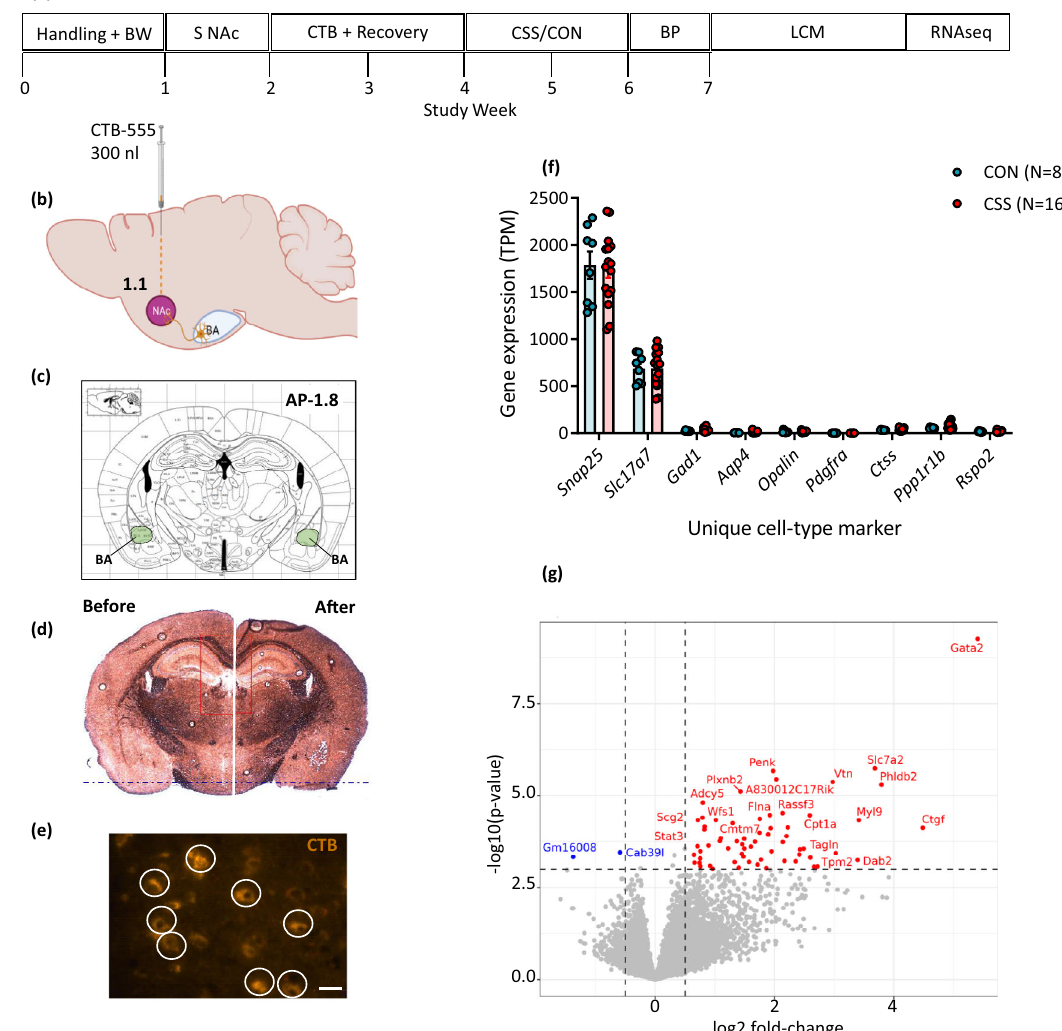
Fig. 3 Effects of CSS on population-level transcriptome expression of BA-NAc neurons. a Experimental design. Handling + BW: daily handling and measurement of body weight; S NAc: stereotactic surgery; CTB + Recovery: CTB transport and recovery from surgery; CSS/CON: CSS protocol or control handling; BP: brains were PBS perfused; LCM: collection of BA-NAc CTB + -labelled tissue using laser capture microdissection; RNA-seq: RNA sequencing and differential gene expression analysis. b Schematic showing bilateral injection site of retrograde CTB Alexa Fluor-555 in NAc. c Coronal image from mouse brain atlas 62 at bregma level − 1.8 mm with BA highlighted. d Representative coronal image (×5) from brain of a CSS mouse at bregma − 1.8 mm before (left) and after (right) collection of CTB-555 + tissue samples using LCM. e Representative coronal image (×40) from a CSS mouse BA at bregma − 1.8 mm: white circles indicate areas of CTB-555 + tissue demarcated for LCM. Scale bar = 200 µ m. f Expression levels (transcript per million) of cell type- speci fi c marker genes: Snap25 neuron, Slc17a7 glutamate neuron, Gad1 GABA neuron, Aqp4 , astrocyte, Opalin myelinating oligodendrocyte, Pdgfra oligodendrocyte progenitor cell, Ctss microglia. g Volcano plot for differential gene expression in CSS compared with CON mice: signi fi cantly up-regulated genes are shown in red and signi fi cantly down-regulated genes in blue. Image b was created with BioRender.com. Image c was used with permission of Elsevier, from The Mouse Brain Atlas, G. Paxinos & K.B.J. Franklin, 2nd edition, 2001; permission conveyed through Copyright Clearance Center,